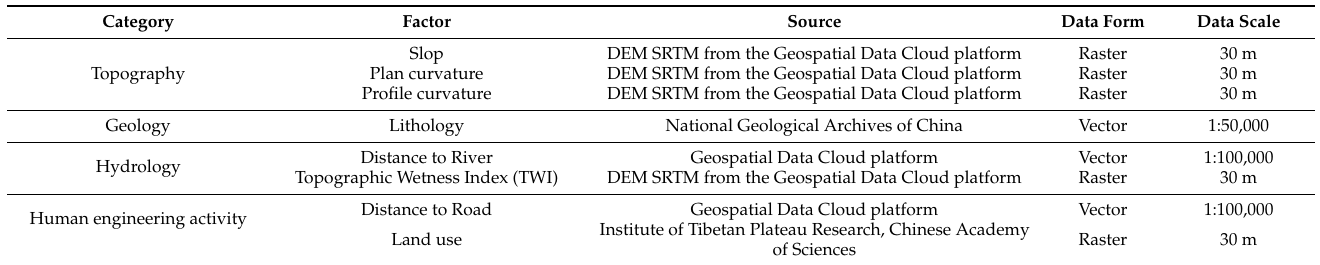
Table 2. Land subsidence factors and sources along transmission lines in the Salt Lake